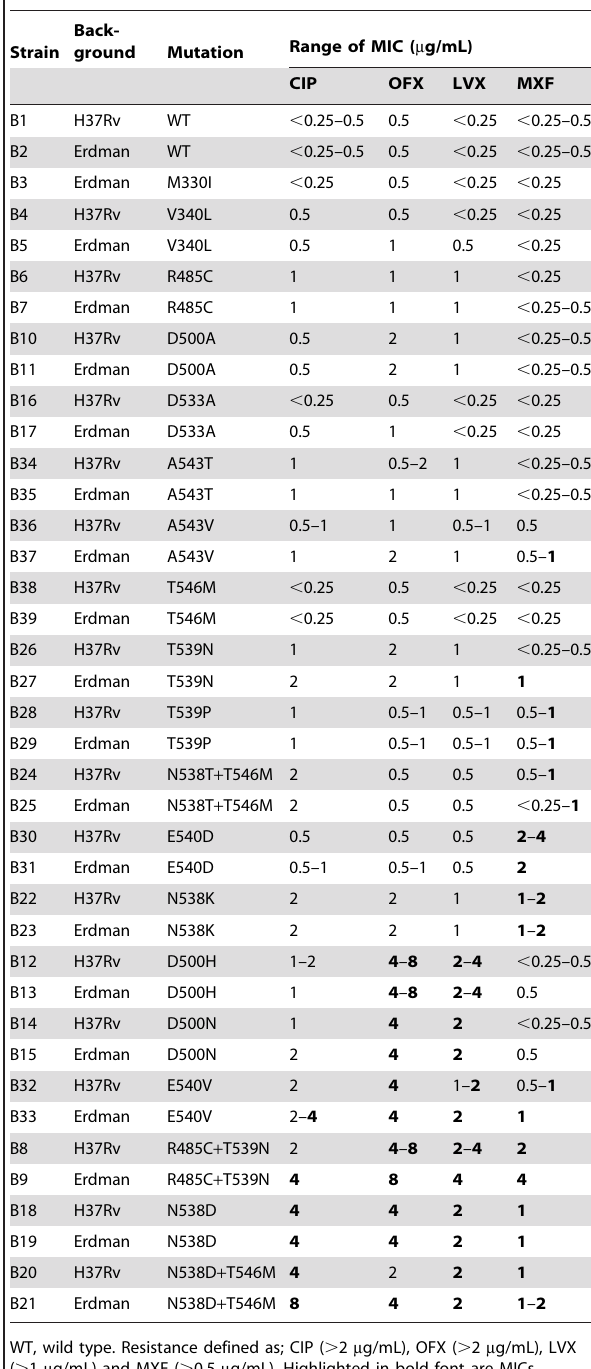
Table 2. MIC of gyrA transductants/mutants. Table 3. MIC of gyrB transductants/mutants.